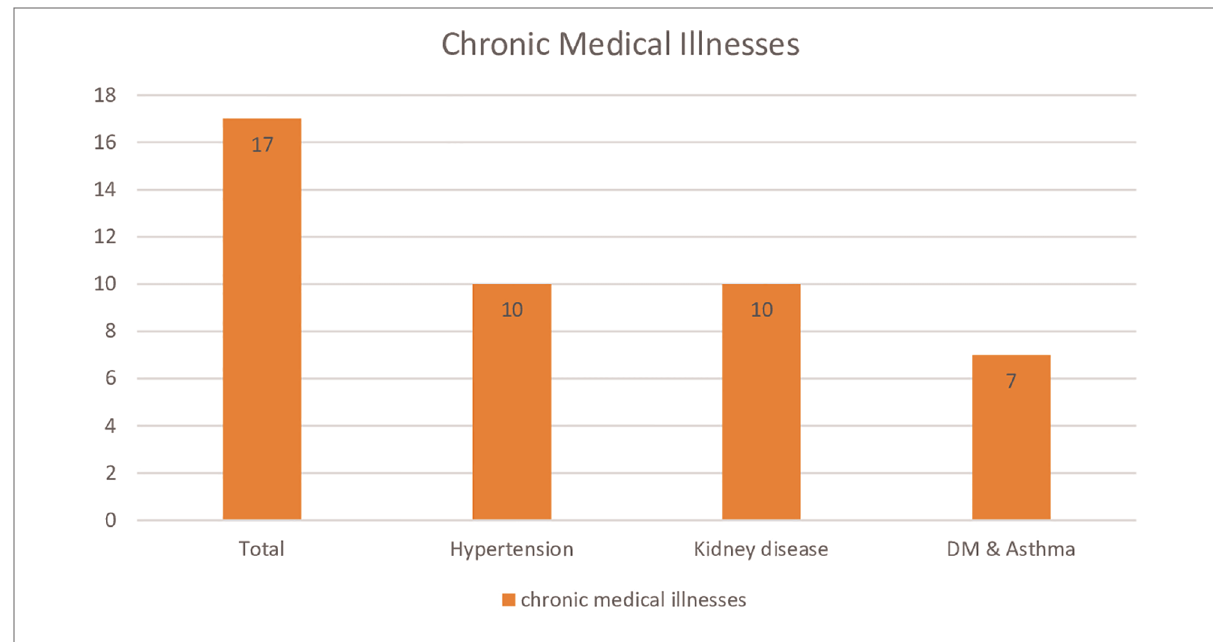
FIGURE 2 Types of chronic medical illnesses among pregnant women.